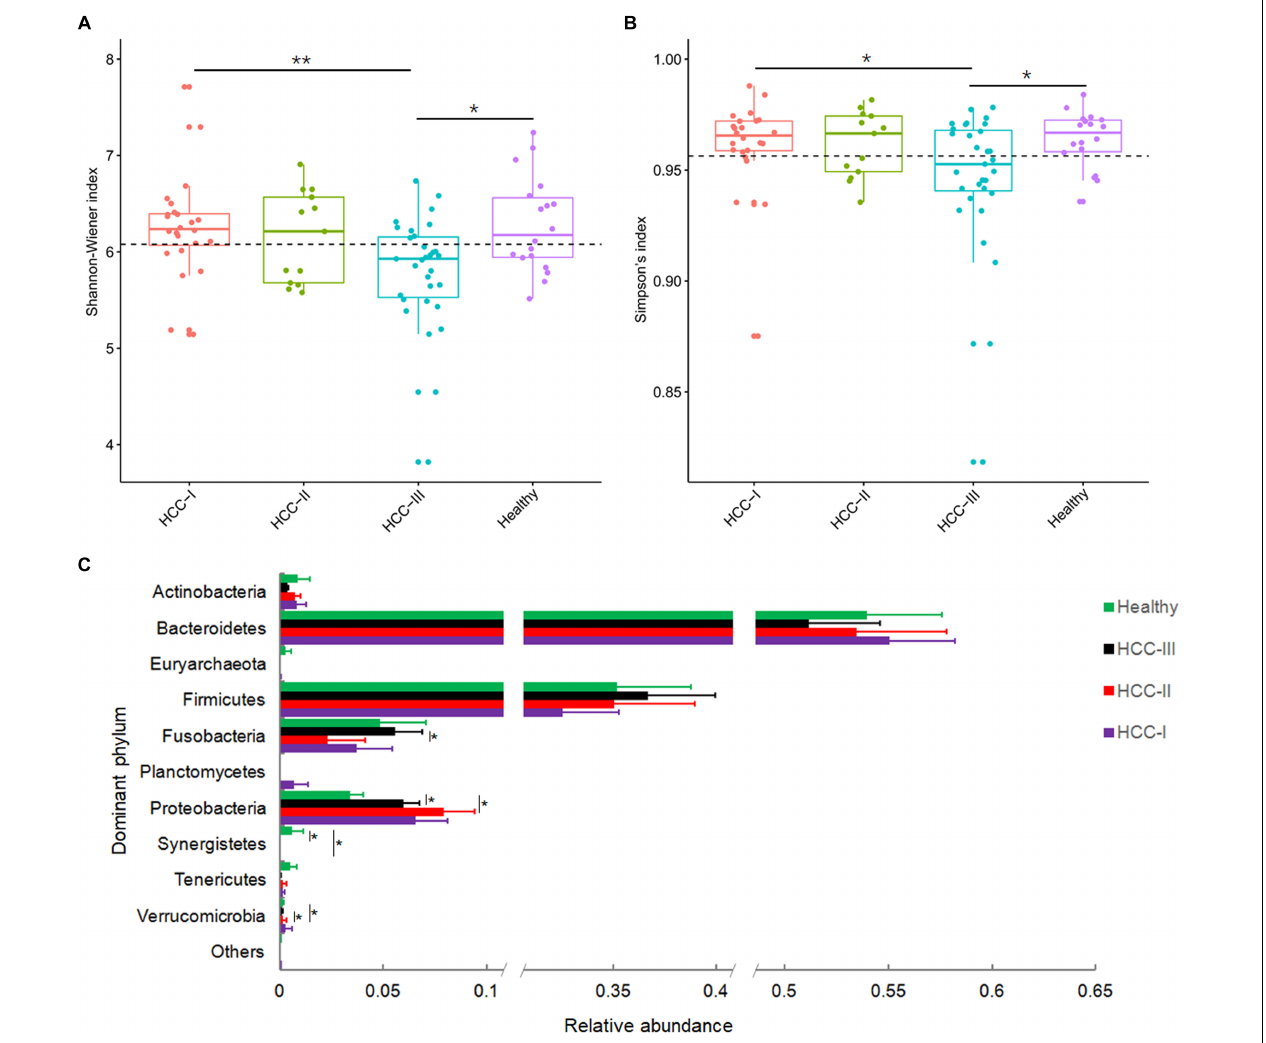
FIGURE 1 | Shannon-Wiener index (A) , Simpson’s index (B) , and relative abundances of the dominant phyla of fecal microbiota from patients with primary hepatocellular carcinoma (HCC) and healthy controls (C) . Patients with primary HCC were staged as described previously (Zhou et al., 2018). ∗∗ p < 0.01; ∗ p <